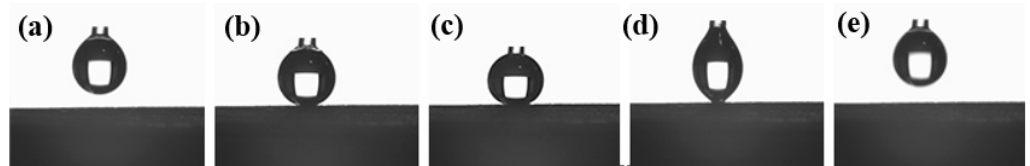
Figure 10. The variation in contact angle of water on the electrodeposited Ni–Co/WS 2 coatings against the concentrations of WS 2 in solution.